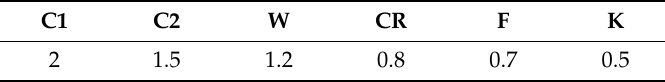
Table 2. Parameter selection of the proposed DEPSO